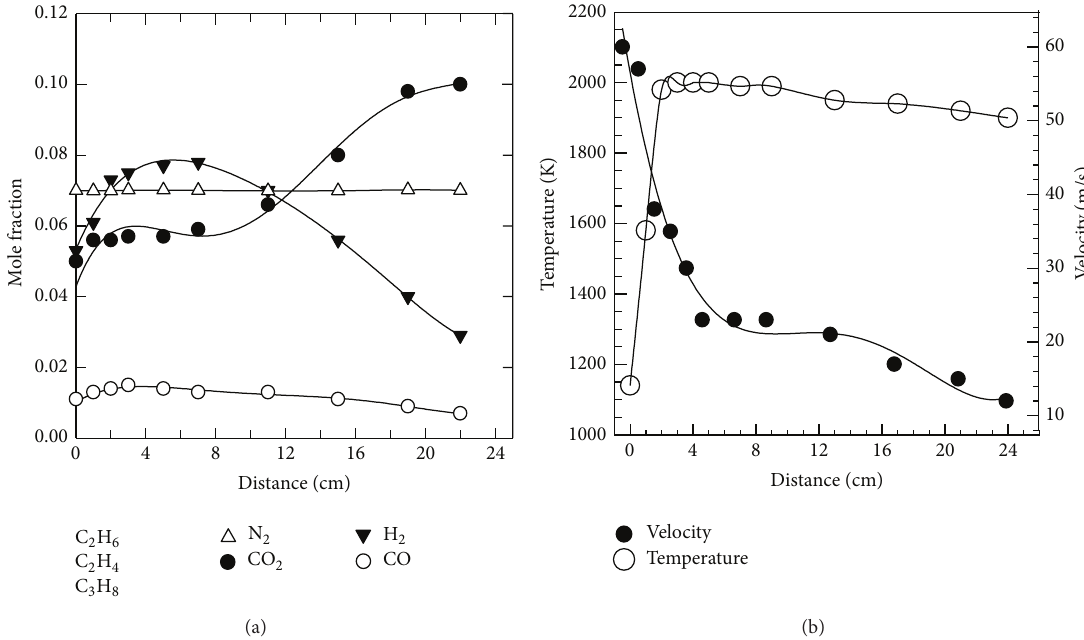
Figure 3: Concentrations, gas flow velocity, and flame temperature for turbulent premixed kerosene-air flame at Reynolds number 12.139 × 10 3 , inlet temperature 573 K, solidity ratio 0.68, equivalence ratio 1.25, and pressure